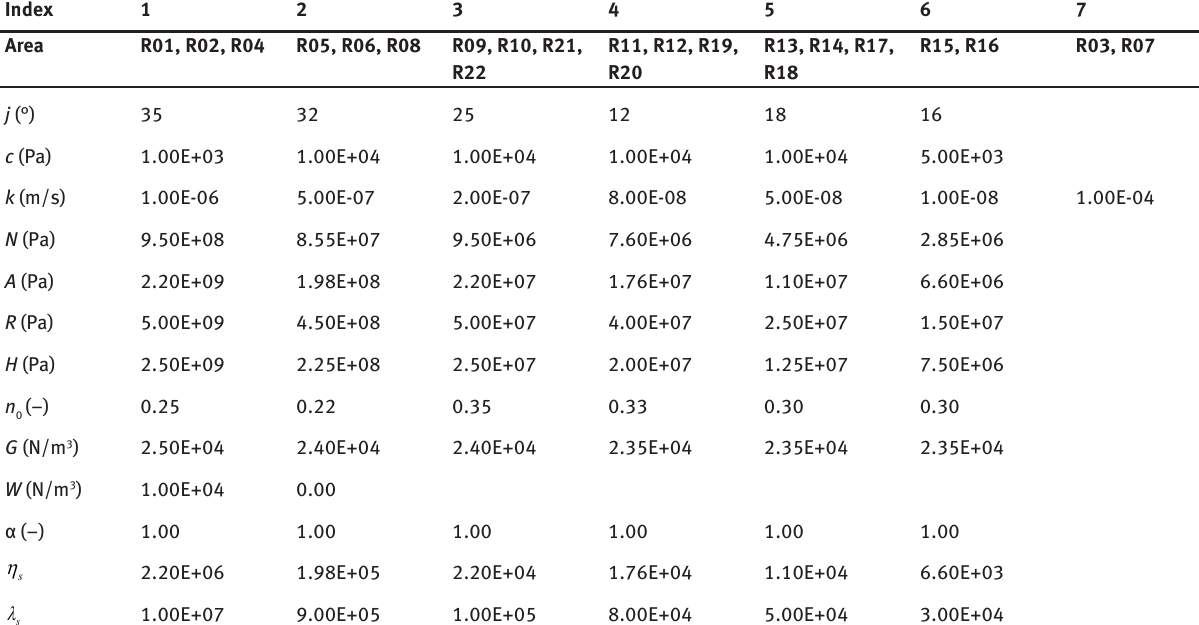
Table 1: Values of the medium parameters (Bartlewska